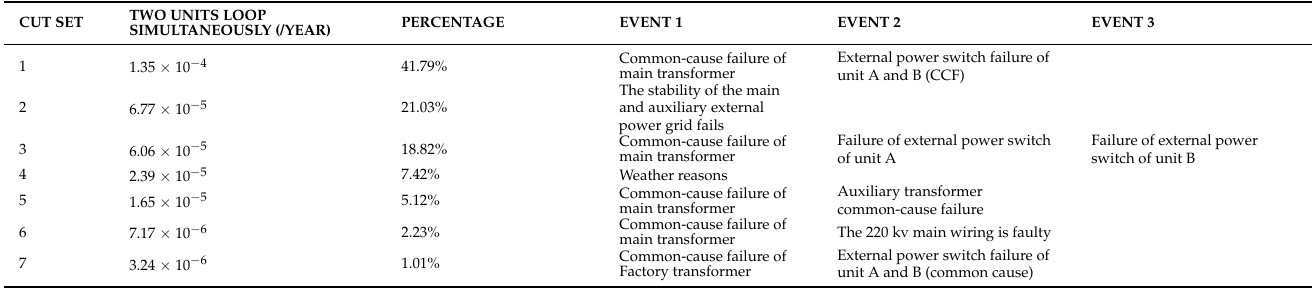
Table 2. Minimum cut set for simultaneous LOOP event of two